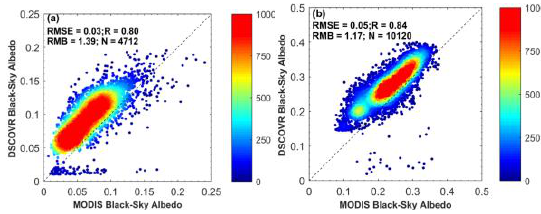
Figure 5. Comparison of black-sky albedo in visible band, (a) Inner Mongolia, (b) Sahara. The colour of a point is